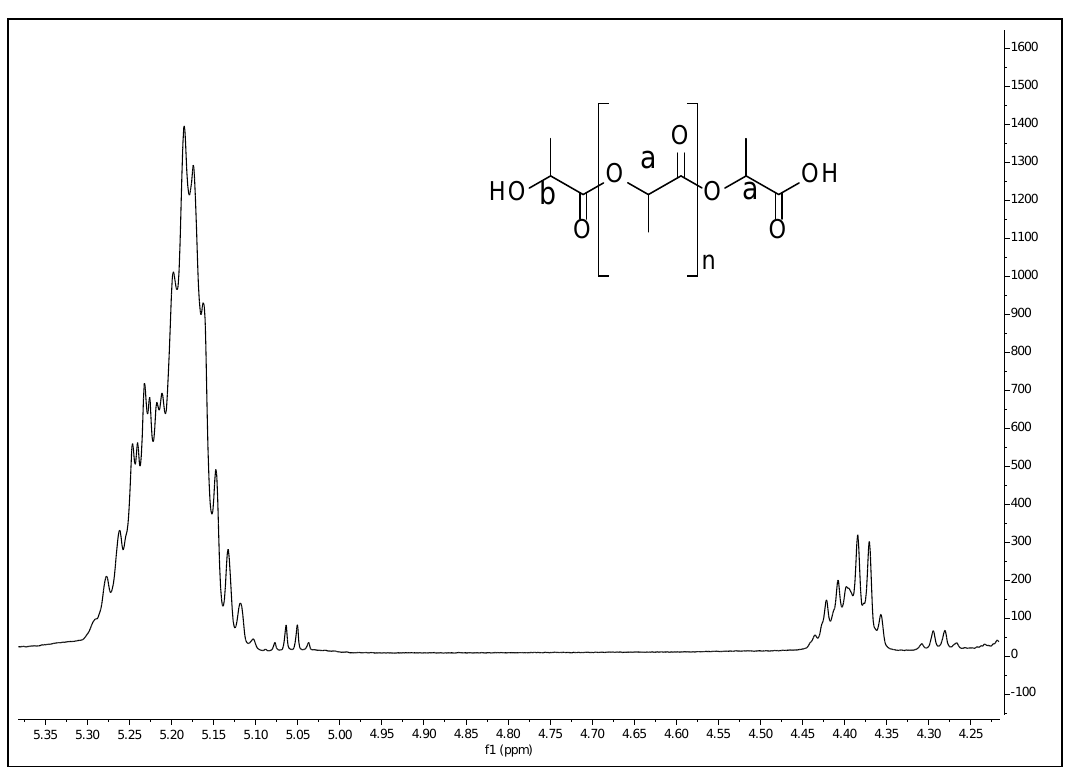
3 for the poly(lactic acid) ( M n (NMR) aprox =